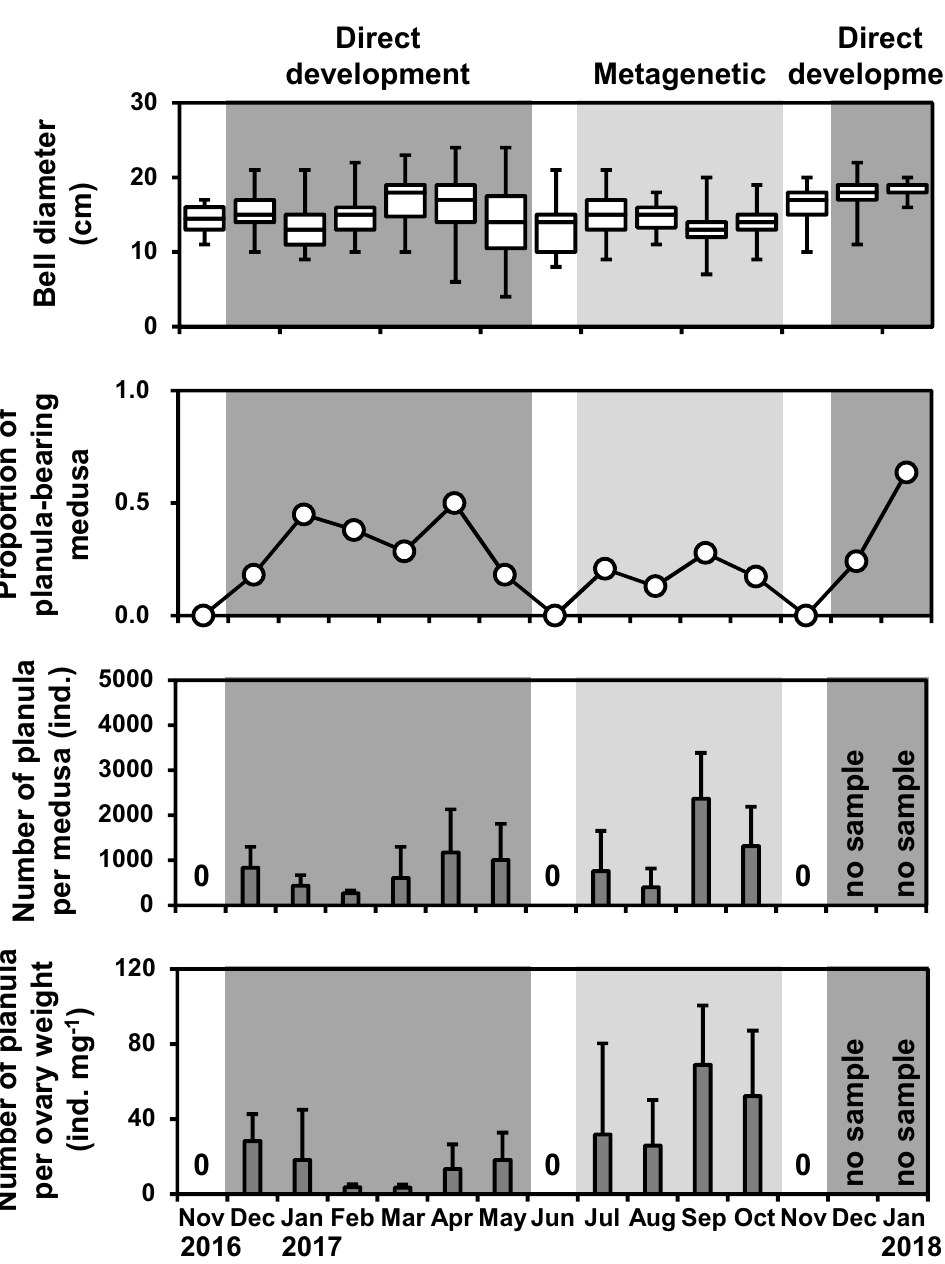
Fig 7. Temporal variations in the bell diameter of medusae, proportion of planula-bearing medusa, and the number of planulae per medusa and per ovary weight. In the top figure, boxes and bars in boxes indicate the first and third quartile and median values, respectively, and bars outside boxes indicate the minimum and maximum values. Bars and error bars in the bottom figure are mean values and SD, respectively. Dark and light shades indicate the direct-development and metagenetic periods,